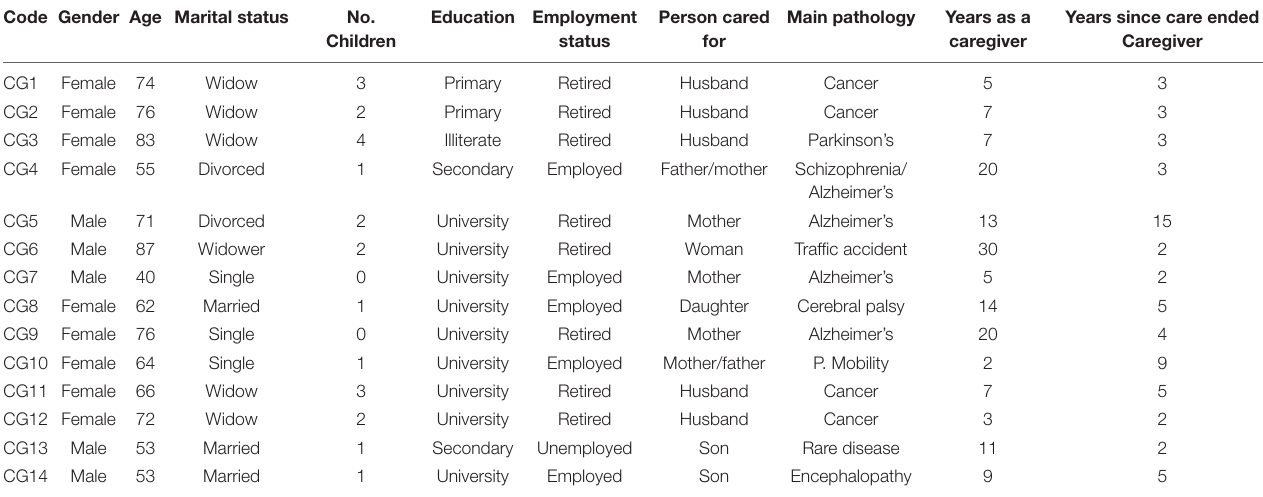
TABLE 1 | Characteristics of the